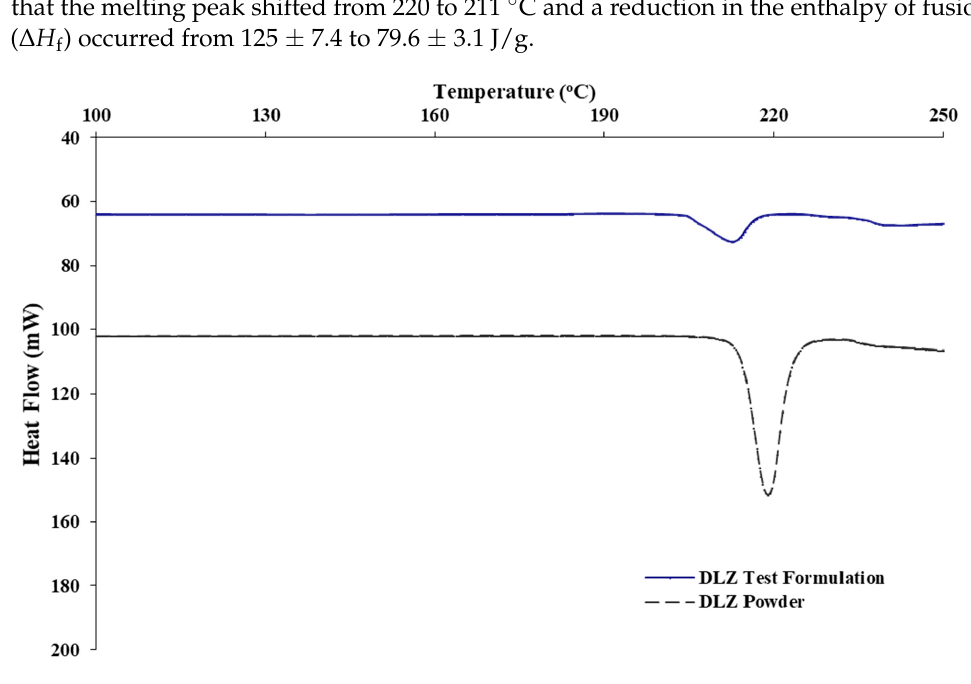
Figure 5. DSC Thermal profile of DLZ dispersion in test formulation and in pure crystalline powder.